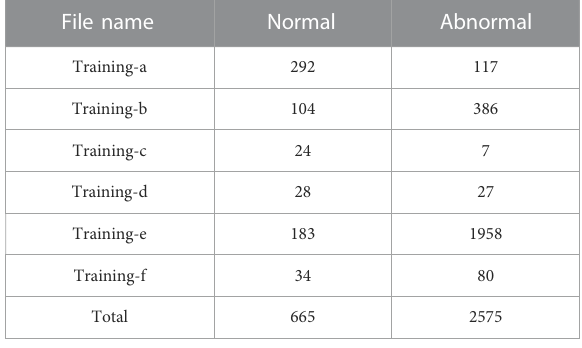
TABLE 1 PhysioNet/CinC Challenge dataset.